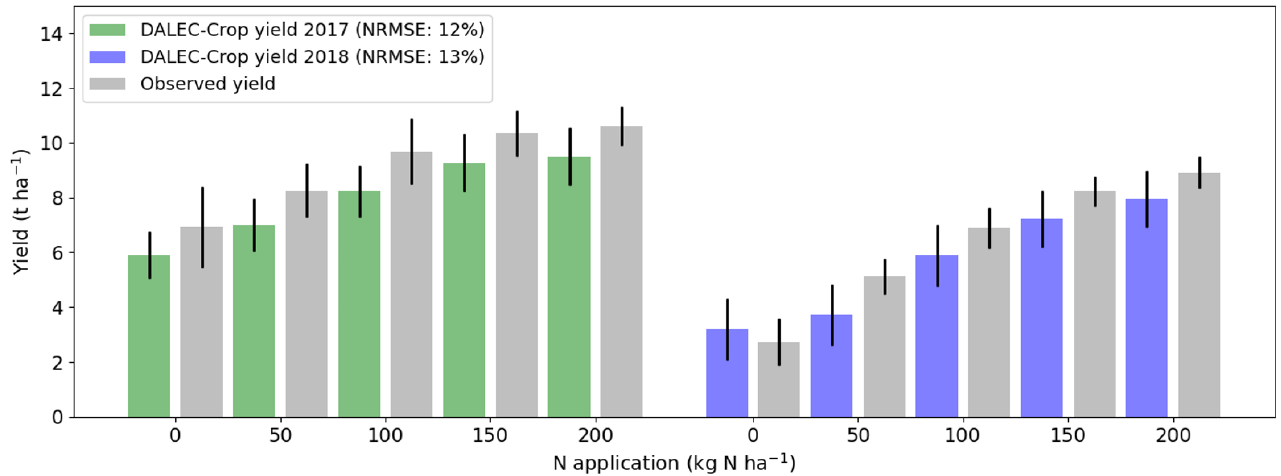
Figure 7. Experiment 1: Evaluating DALEC-Crop for the retrieval of wheat yield when constraining the model based on LAI observations. Experiment applied using the multi-year model calibration applied at all trial plots for the 2016–2017 (green) and 2017–2018 (blue) growing seasons. Error bars represent the standard deviation of the distribution of modelled yield values for each treatment. Note: NRMSE is calculated from independent yield